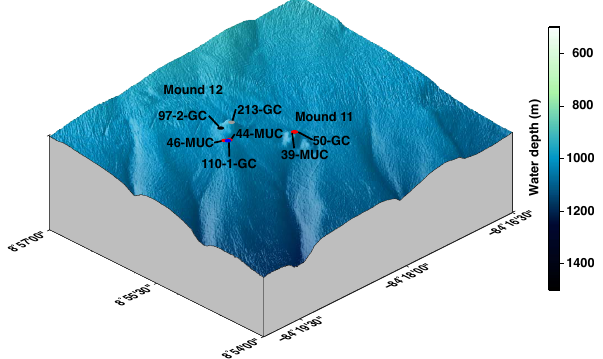
Fig. 2. 3-D relief map of the study area offshore of Costa Rica show- ing stations at Mound 11 and 12 sampled during expeditions SO206 (red), SO173 (blue), M66 (grey), and M54 (black).